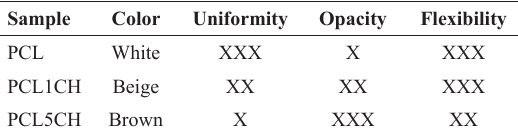
Table 1: Macroscopic examination of PCL film and PCL-coffee husk composite films. Sample